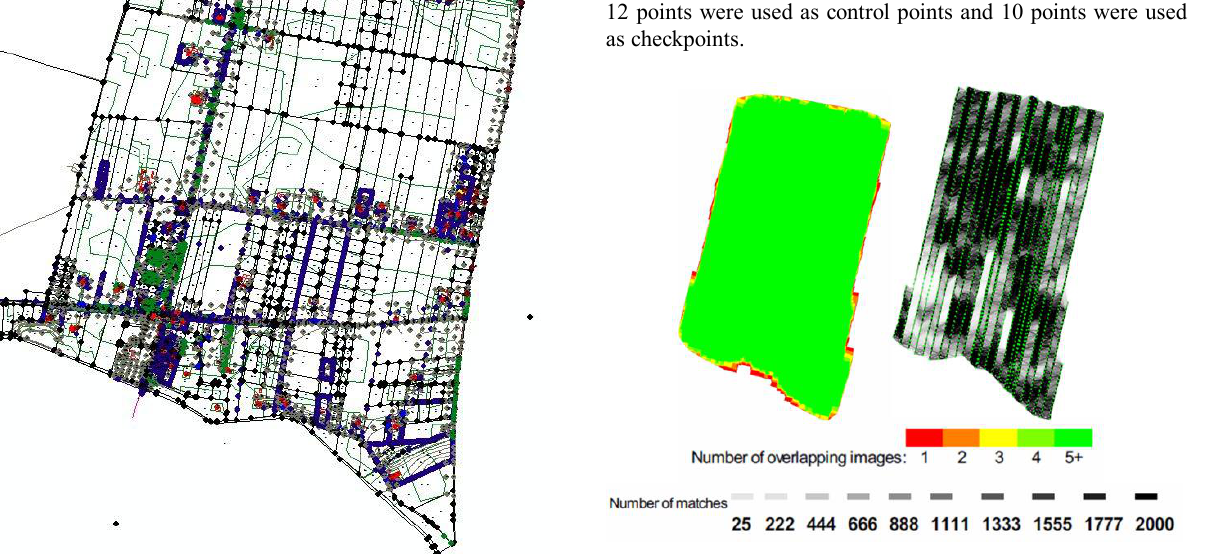
Figure 5. The relative overlap between images and the spatial Figure 3. The vector form of cadastral data after updating with distribution of the number of image traditional methods